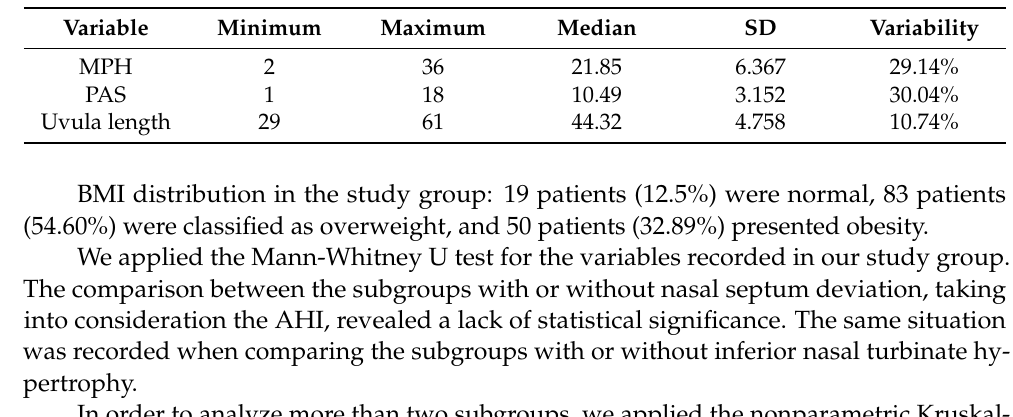
Table 1. Descriptive statistics of the main cephalometric variables in the study group.